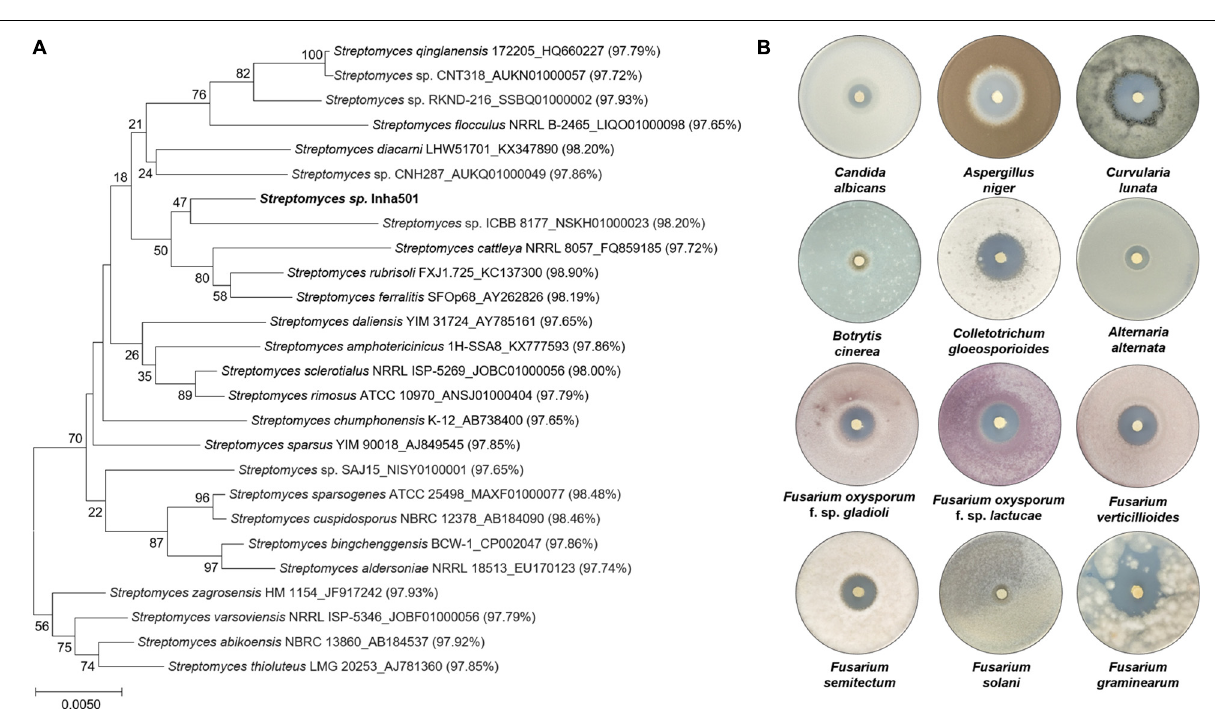
Frontiers in Bioengineering and Biotechnology |